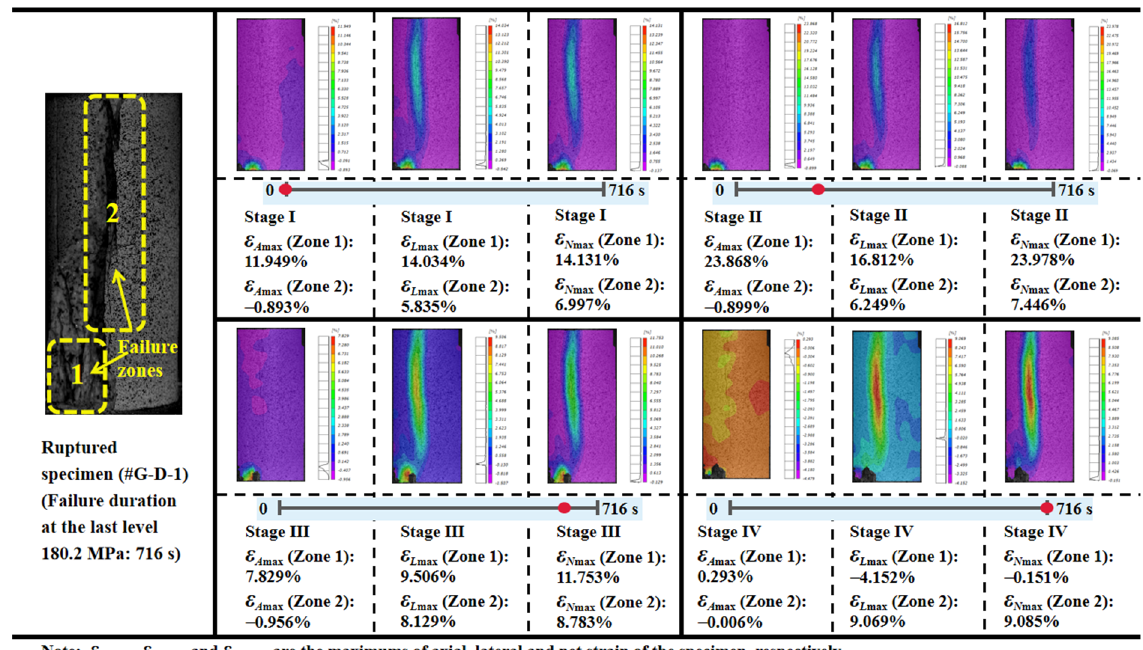
Figure 9. Maximum deformation of granite in failure areas during the last stress stage (180.2 MPa).